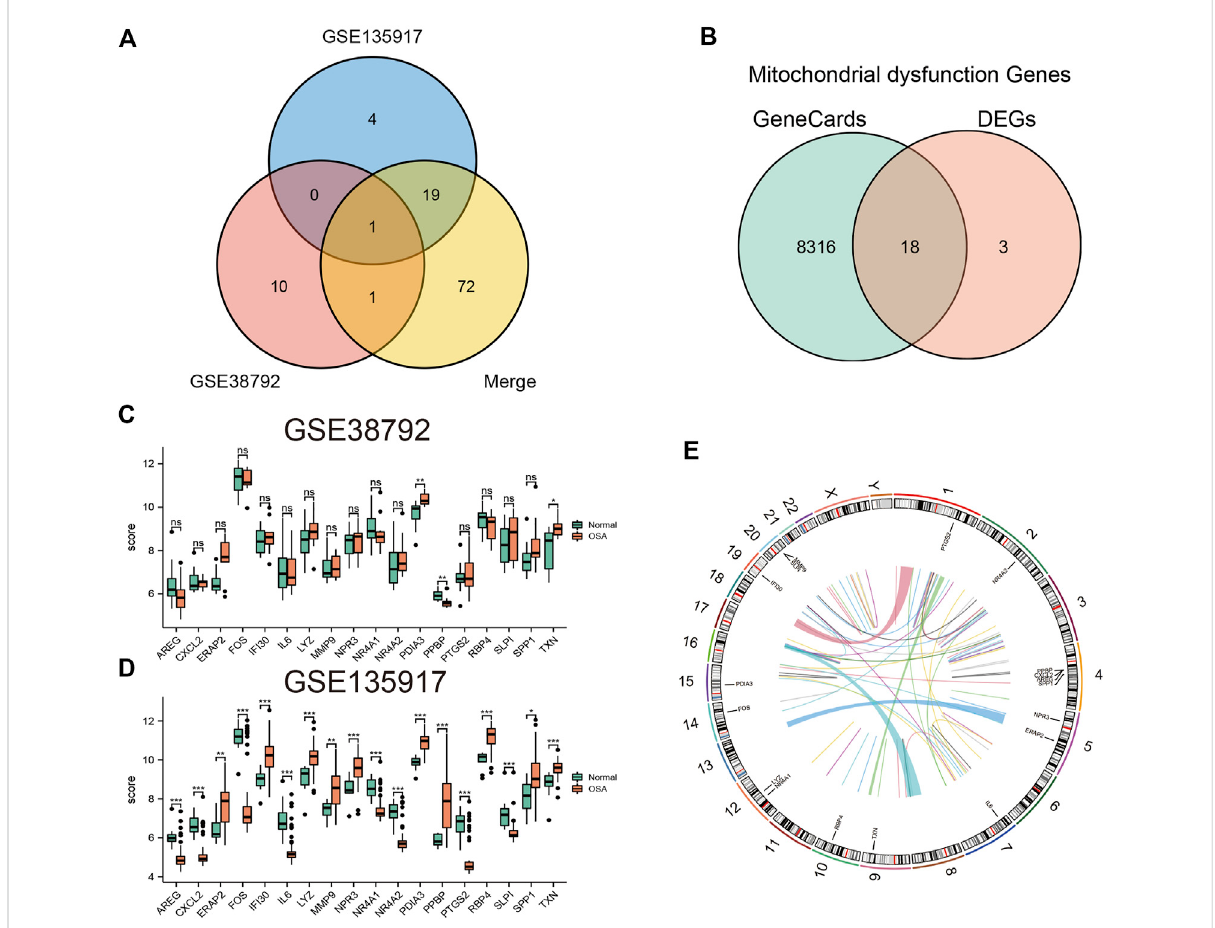
FIGURE 2 Identi fi cation of mitochondrial dysfunction-related hub genes. (A) Venn diagram of DEGs between the OSA and control samples in the GSE135917, GSE38792, and combined datasets. (B) Venn diagram of hub DEGs and mitochondrial dysfunction-related genes. Boxplots of the differences in expression of mitochondrial dysfunction-related hub genes in (C) GSE38792 and (D) GSE135917 datasets. (E) Chromosomal positions and expression of mitochondrial dysfunction-related hub genes. * p < 0.05, ** p < 0.01, *** p < 0.001, ns: no signi fi cant difference. DEGs: differentially expressed